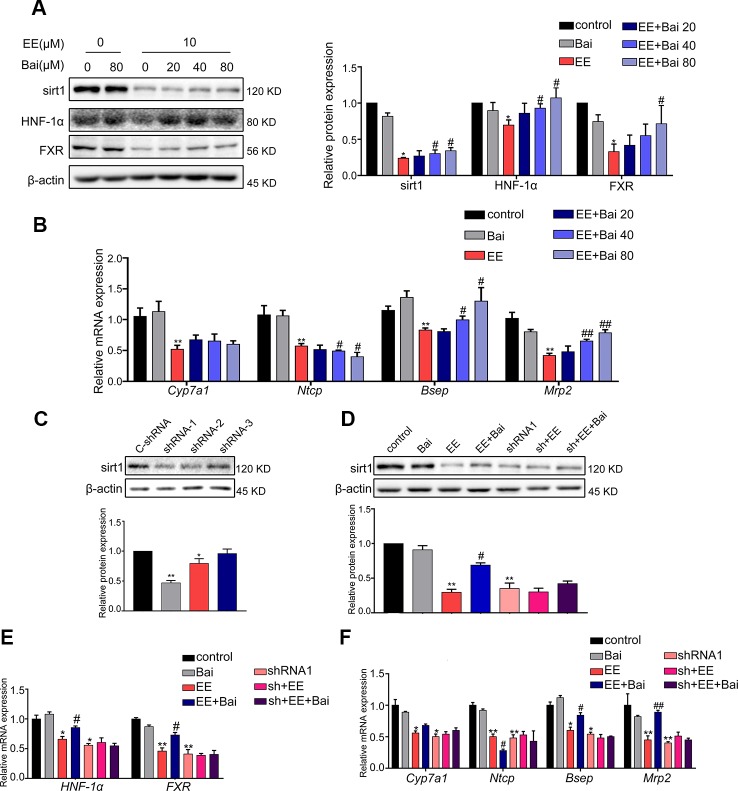
Effect of baicalin on Sirt1, HNF-1α, FXR, and FXR target genes in vitro. (A) HepG2 cells were treated with EE (10 μM), and baicalin (20, 40, 80 μM), and incubated with EE for 24 hours. EE inhibited the protein expression of Sirt1, HNF-1α, and FXR, which was reversed by baicalin treatment in a dose-dependent manner. (B) The mRNA expression of Cyp7a1, Ntcp, Bsep, and Mrp2 in HepG2 cells treated with EE (10 μM), and baicalin (20, 40, 80 μM) for 24 hours. (C) The protein level of Sirt1 in HepG2 cells, which were transduced with shRNA targeting Sirt1 (shRNA 1-3) or negative control (C-shRNA) for 72 hours. (D) The protein expression of Sirt1 in HepG2 cells treated with EE (10 μM), baicalin (80 μM), EE (10 μM) with baicalin (80 μM), and shRNA1. (E) The mRNA expression of HNF-1α and FXR in HepG2 cells treated with EE (10 μM), baicalin (80 μM), and shRNA1. (F) The mRNA expression of Cyp7a1, Ntcp, Bsep, and Mrp2 in HepG2 cells treated with EE (10 μM), baicalin (80 μM), and shRNA1. Data are presented as the mean ± SD (n = 3). *p < 0.05 and **p < 0.01 versus the control group, #p < 0.05 and ##p < 0.01 versus the EE group.